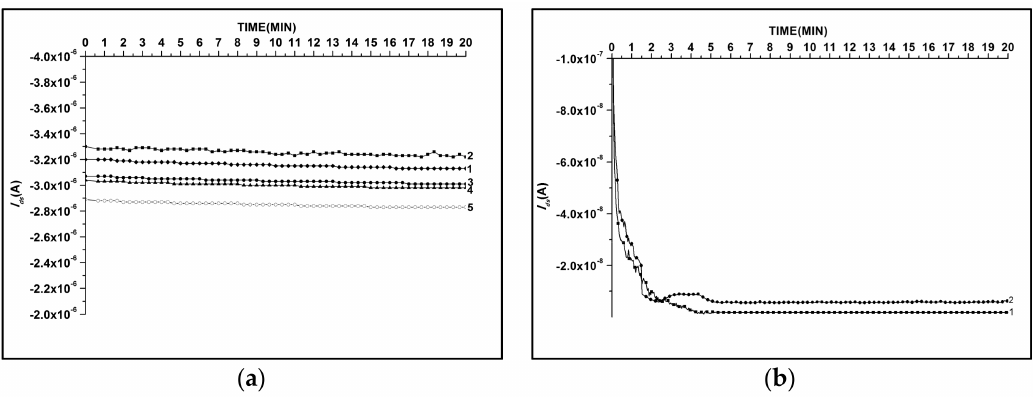
Figure 4. Comparison of typical I ds ( t ) dependencies obtained for (h-k)-SOI-NW chip ( a ) and for SOI-NW chip with native oxide ( b ). Numbers indicate curves obtained for different sensors.